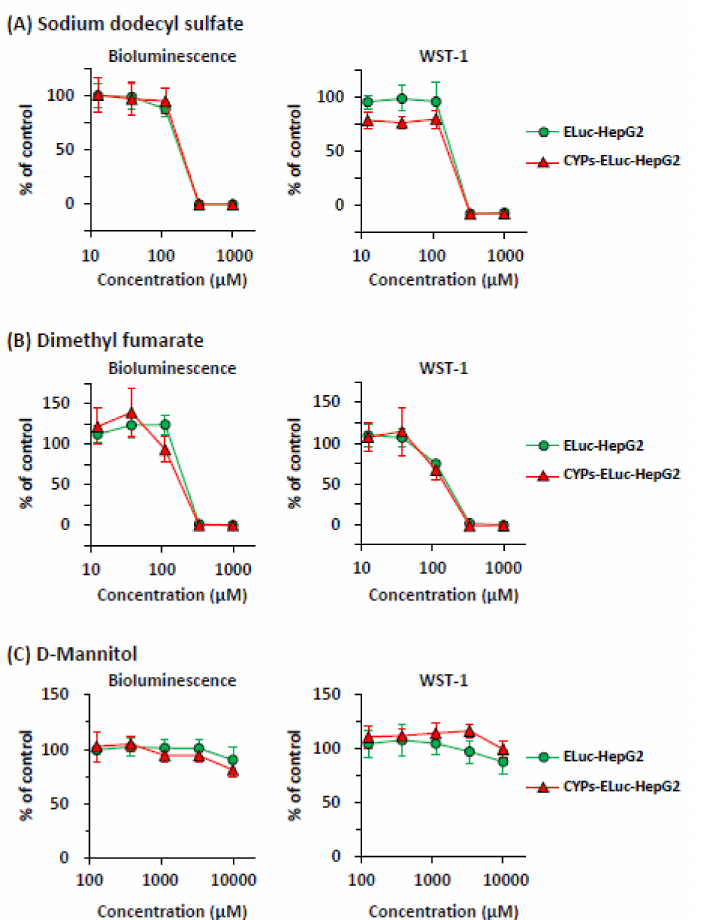
Figure 2. Effects of SDS, dimethyl fumarate, and D-mannitol on bioluminescence intensity and viability measured by WST-1 assay in ELuc-HepG2 and CYPs-ELuc-HepG2 cells. After the cells were treated with SDS ( A ), dimethyl fumarate ( B ), and D-mannitol ( C ) for 3 days, bioluminescence intensity was measured non-destructively for 5 s (left panels). Then, the WST-1 assay was conducted using the same cells (right panels). Data are expressed as percentage of vehicle control cells (set at 100%) and shown as means ± standard deviations ( n =